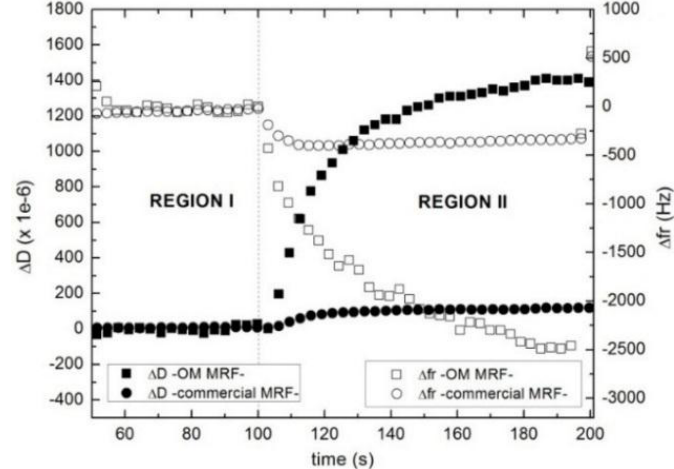
Figure 6. Dissipation (full dots) and resonance frequency shift (open dots) of OM MRF (squares) and commercial MRF (circles) as a function of time at 8 MHz. In region I (pre-shear stage) the MR fluids are subjected to a constant shear rate (100 s −1 ). In region II, the shear is turned off, letting the structure approach equilibrium.